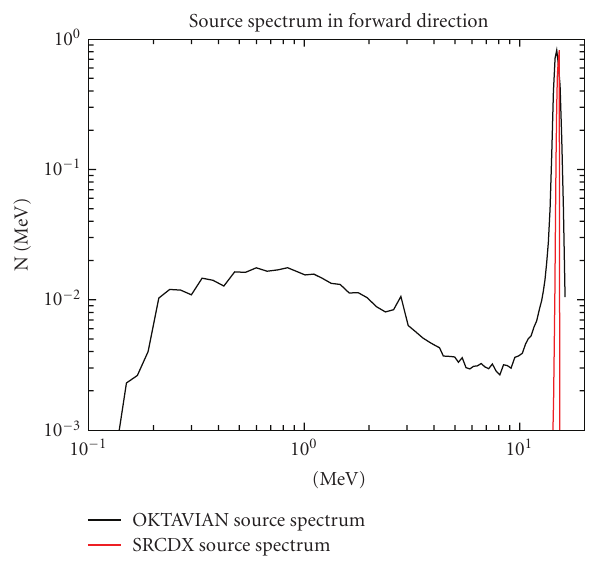
Figure 9: Comparison of OKTAVIAN source spectrum in forward direction versus the one generated by the SRCDX subroutine.